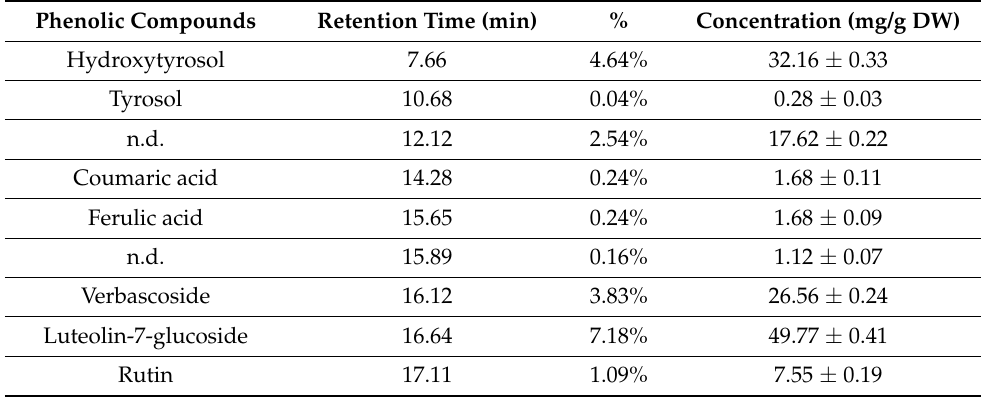
Table 1. Relative quantities (%) of identified phenolic compounds in olive leaves extracts. Values are expressed as mg/g extract of oleuropein